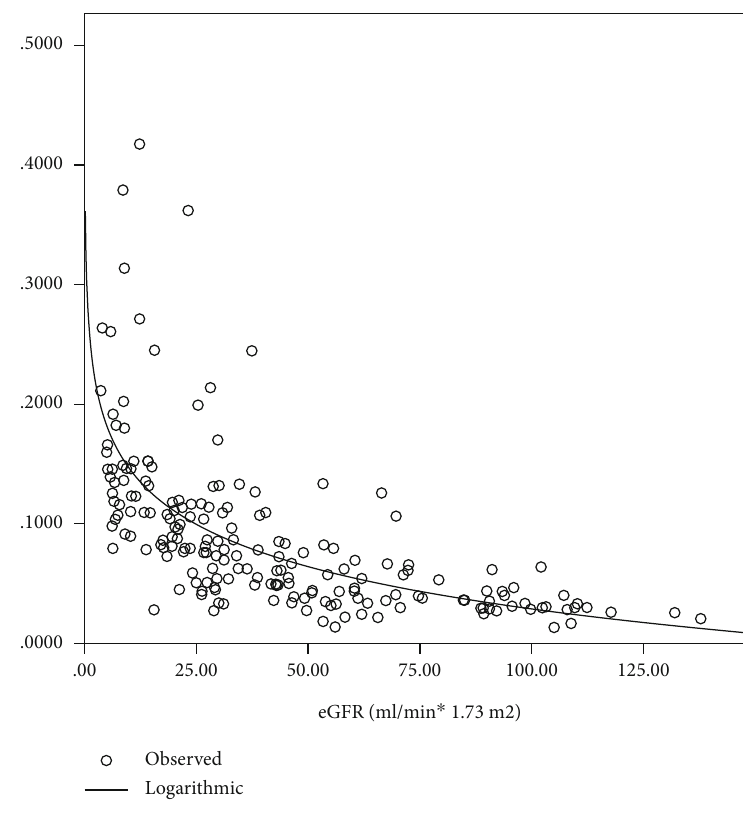
Figure 1: Estimated curve between IDO and eGFR. Table 3: Binary logistic analysis of independent risk factors of chronic kidney